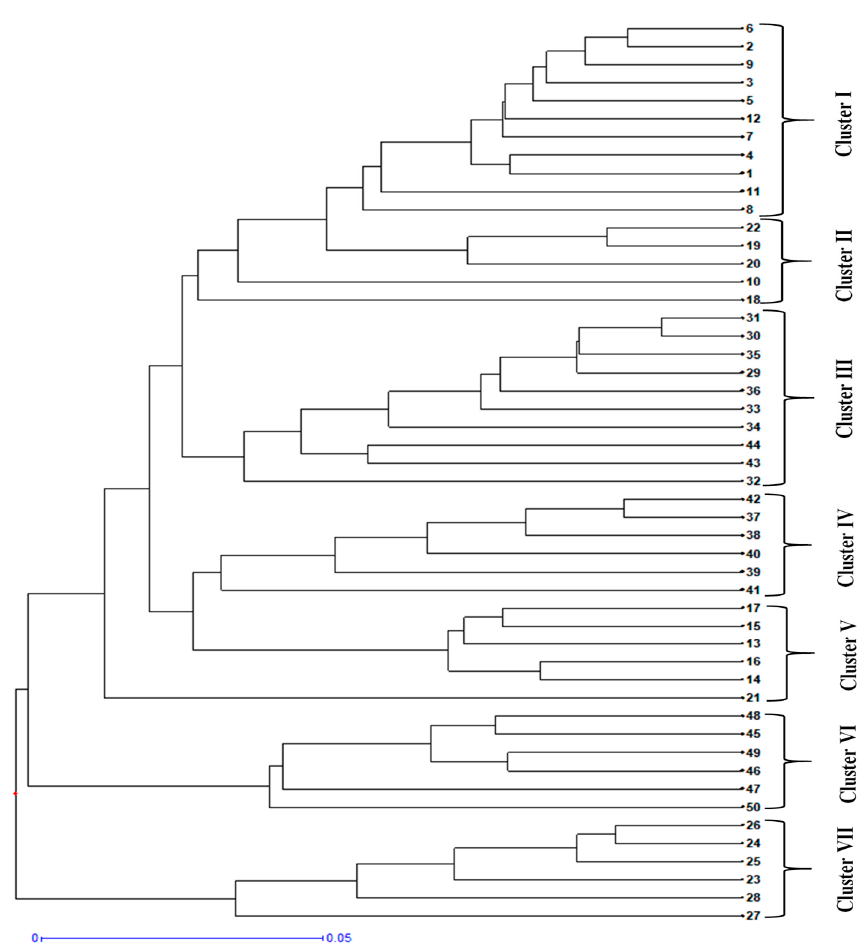
Figure 6. UPGMA hierarchical dendrogram of 50 accessions of C. intybus based on ISSR marker data using Jaccard’s dissimilarity coefficient.